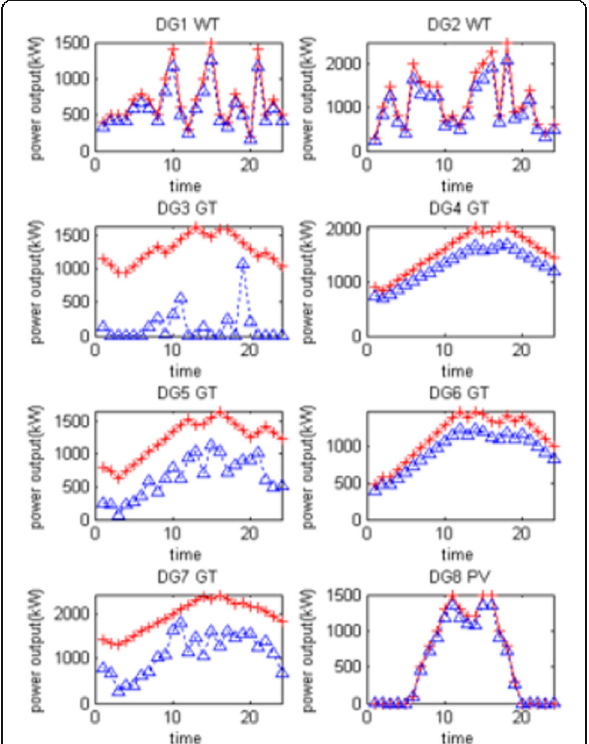
Fig. 15 Active power schedule of the storage battery